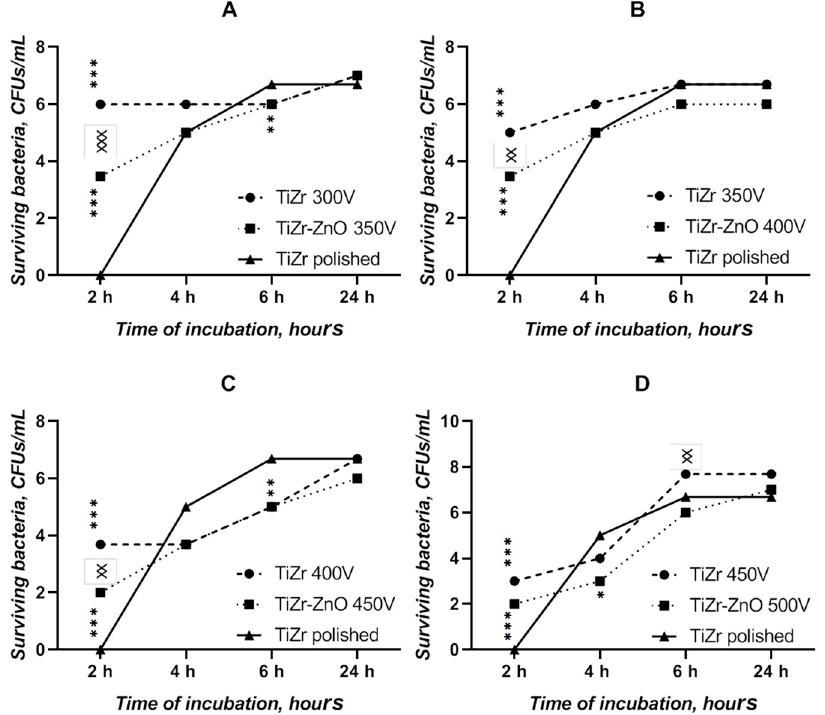
Figure 10. Comparison of the time-dependent adhesion effect of TiZr and TiZr-ZnO samples ( A )—samples TiZr-300-ZnO and TiZr-350-ZnO, ( B )—TiZr-350-ZnO and TiZr-400-ZnO, ( C )—TiZr-400-ZnO and TiZr-450-ZnO, and ( D ) − TiZr-450-ZnO and TiZr-500-ZnO. * − significant difference ( p ≤ 0.05) between PEO coated samples and polished control (** − p ≤ 0.01 and *** − p ≤ 0.001), x—significant difference ( p ≤ 0.05) between TiZr and TiZr-ZnO samples.